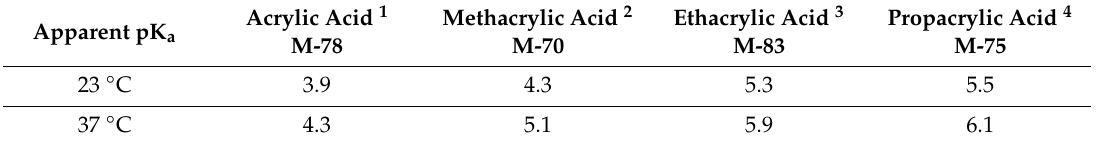
Table 2. Apparent pK a Values of the N -isopropylacrylamide Copolymers at 23 ◦ C and 37 ◦